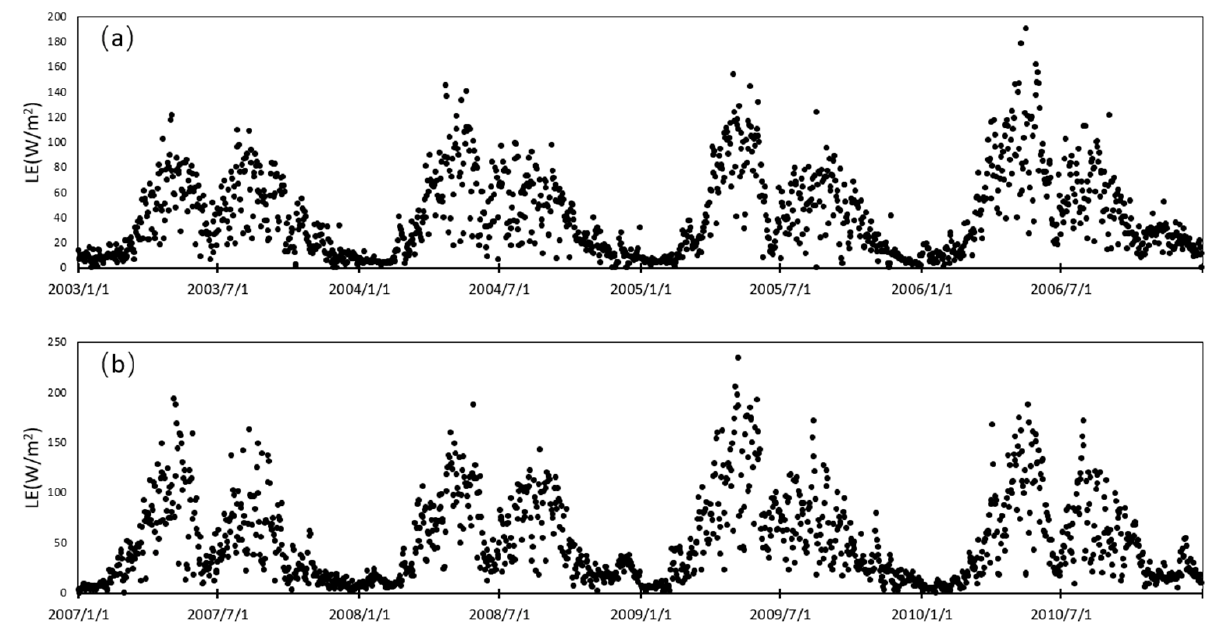
Figure 3. Daily Latent Heat Flux (LE) data of Yucheng EC station in 2003–2006 ( a ) and 2007–2010 ( b ).